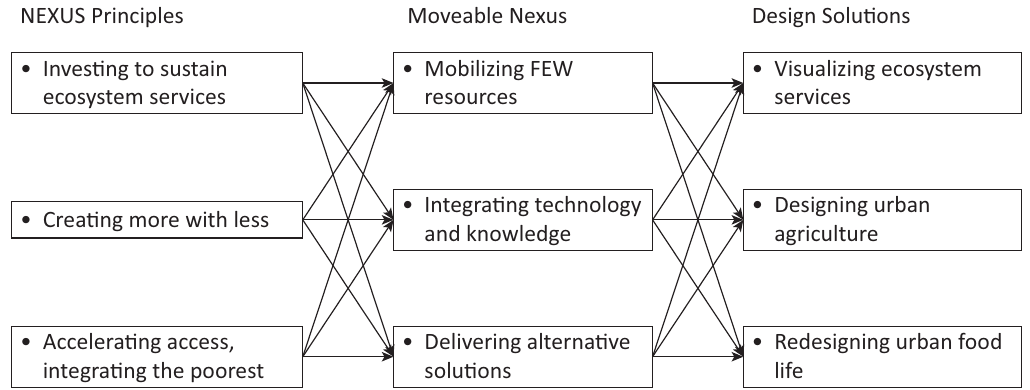
Figure 1. Principle of nexus thinking and moveable nexus. Source: